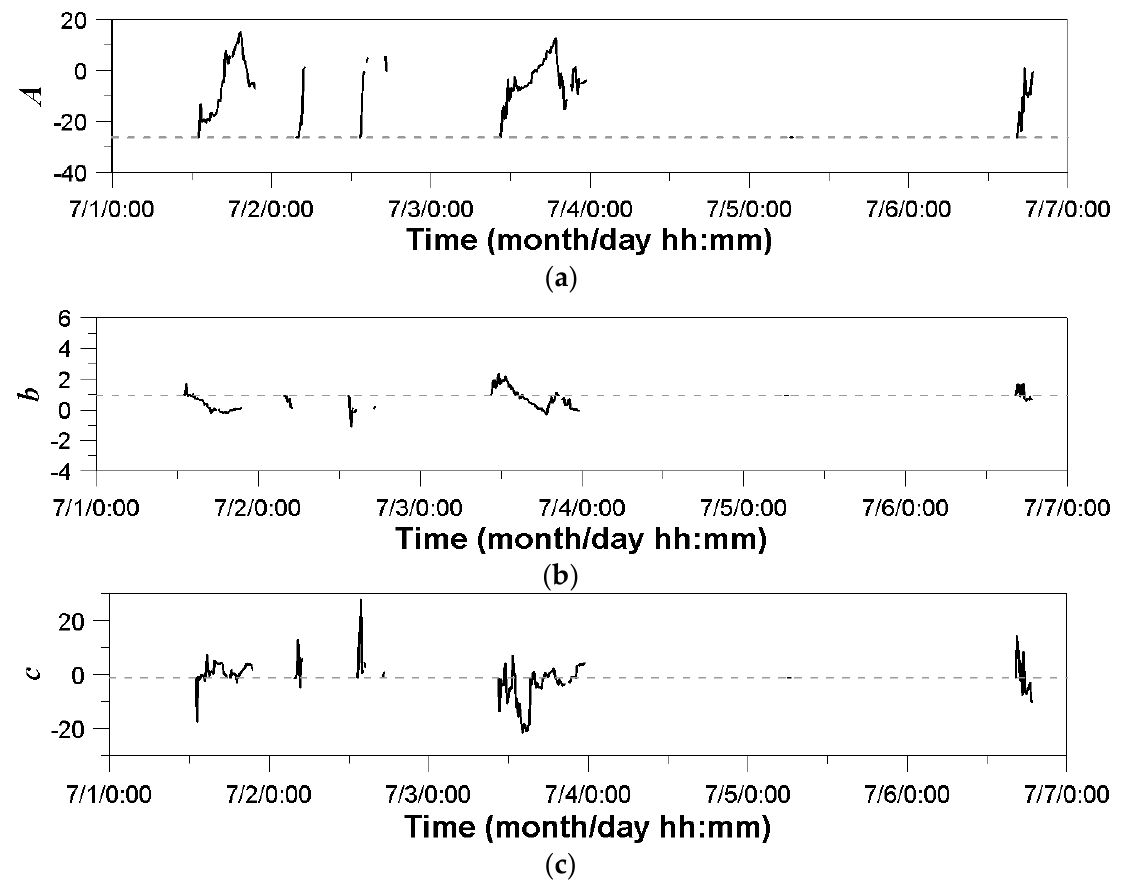
Figure 5. Resulting time series plots of parameters at the Shinpo rain gauge station (No. 936) estimated by applying the extended Kalman filter: ( a ) parameter A , ( b ) parameter b , ( c ) parameter c.